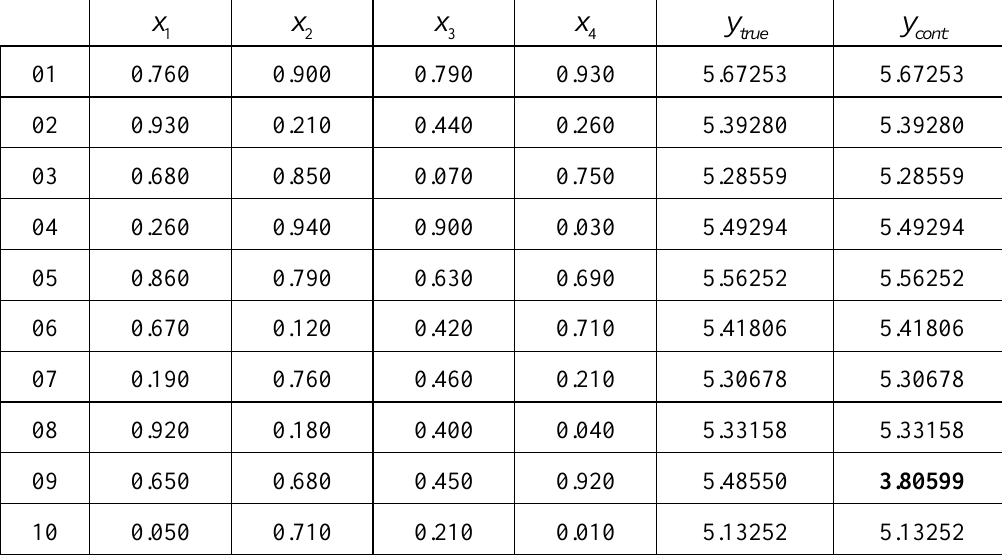
Table 1. Tanning data with and without contaminations used for verifying the proposed NACI model and LTS-MQPSO